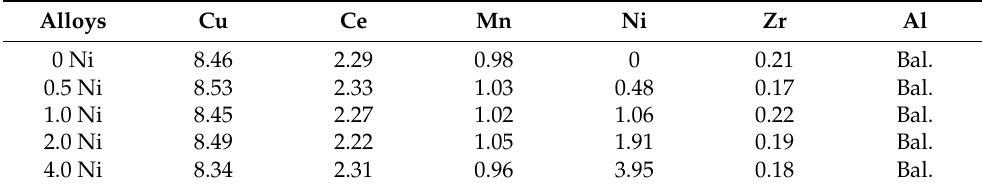
Table 1. Chemical compositions of as-cast Al-8.4Cu-2.3Ce-1.0Mn-0.5Ni-0.2Zr-xNi alloys (weight percent). Alloys